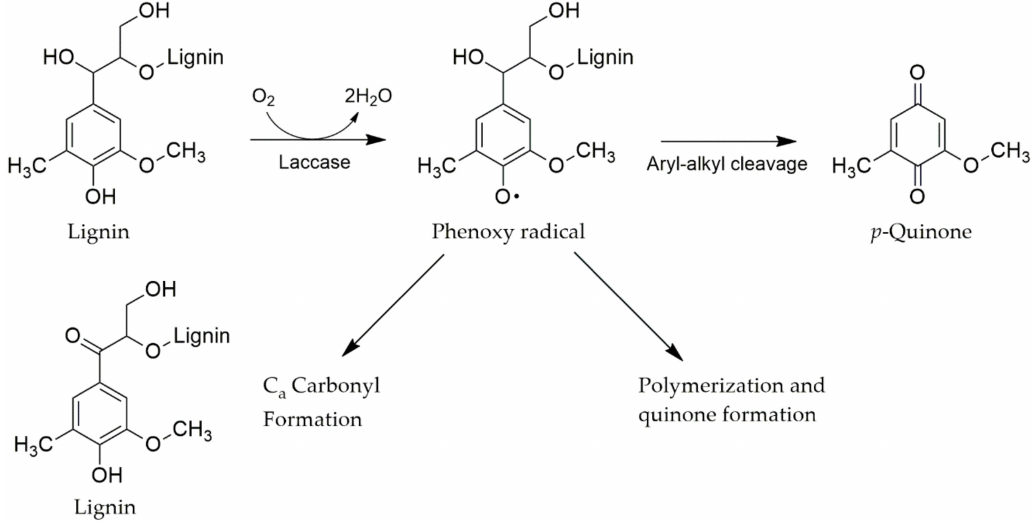
Figure 9. Typical reaction of laccase on phenols oxidation modifled from Minussi et al.